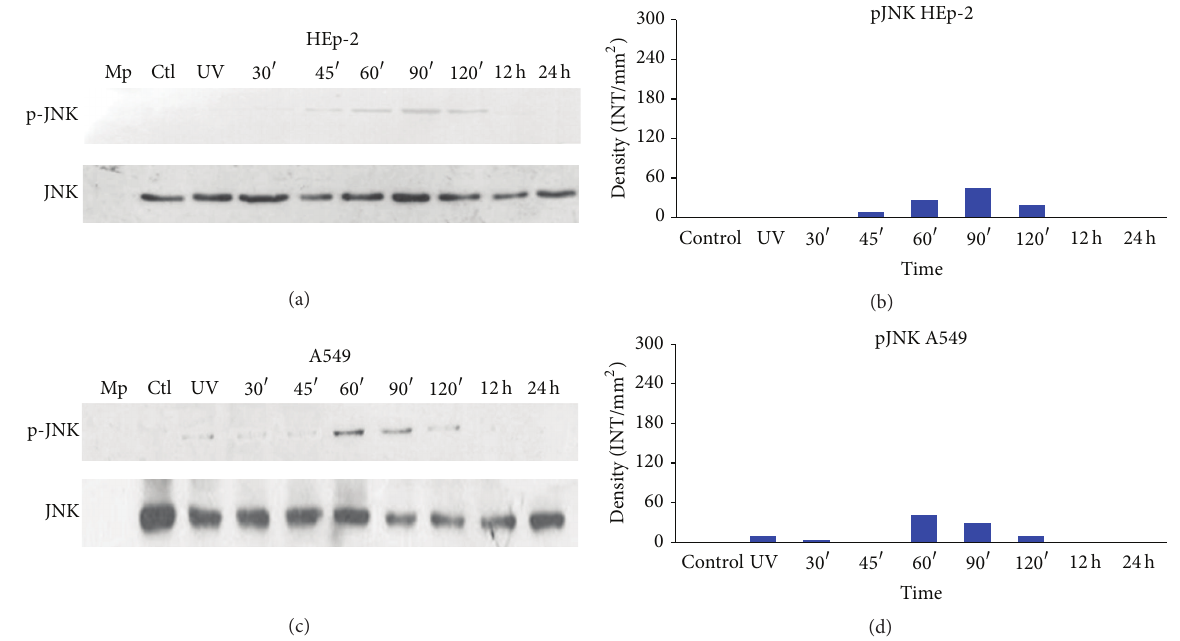
Figure 6: JNK phosphorylation. Detection of JNK phosphorylation in HEp-2 and A549 cells infected with HPIV-1. Cells were infected with live and inactive HPIV-1 at different time points, and JNK phosphorylation was detected. Whole cell lysates were prepared for Western blotting (as described in Materials and Methods) to detect the phosphorylated (active) forms of the kinases: (a) phospho-JNK was detected with monoclonal antibody sc-135642 and the total JNK sc-571 in HEp-2 cells; (b) densitometric analysis of JNK protein concentrations; (c) phospho-JNK and total protein concentrations in A549 cells; (d) densitometric analysis of the protein concentrations. Mp: molecular weight; CTL: control and UV (inactive virus) that corresponds to 12 hours in path 3. Data are the means for triplicate measurements from the three separate